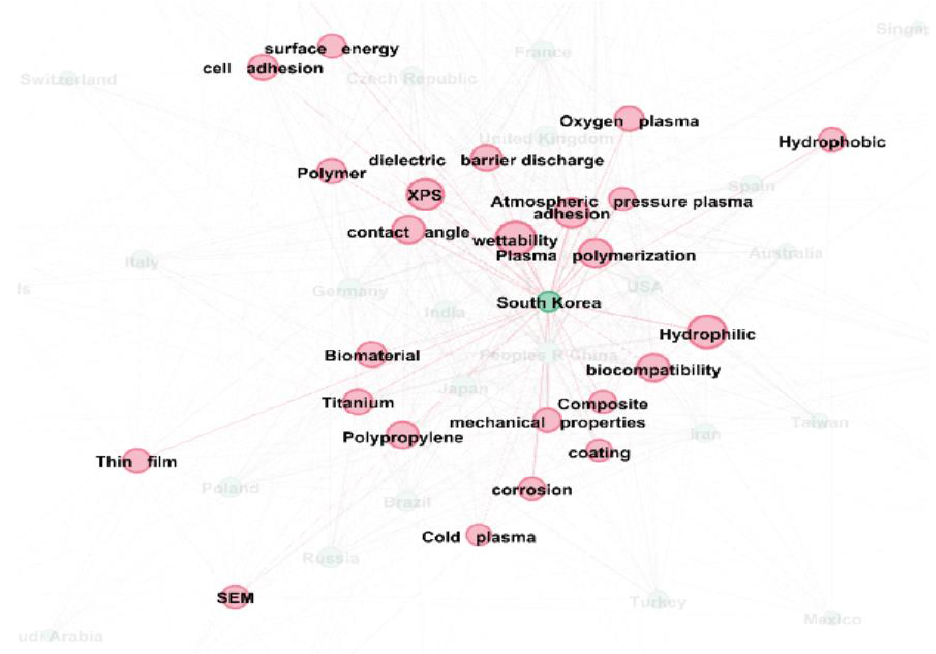
Figure 7. Sub- network ‘Korea’ of country– author keyword network. Figure 7. Sub-network ‘Korea’ of country–author keyword